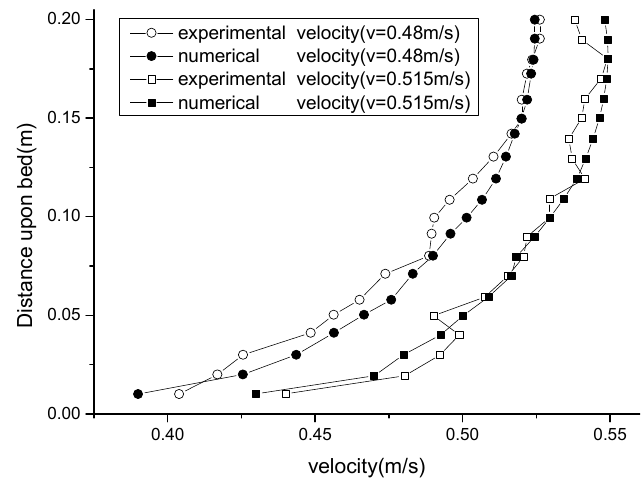
Figure 5. Comparison between the numerical and experimental streamwise velocity at the line AB with two cases of cross-sectional average velocity 0.48 and 0.515 m/s.